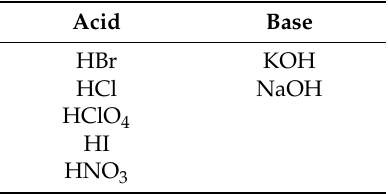
Table 1. Acids and bases extracted from the aqueous phase.